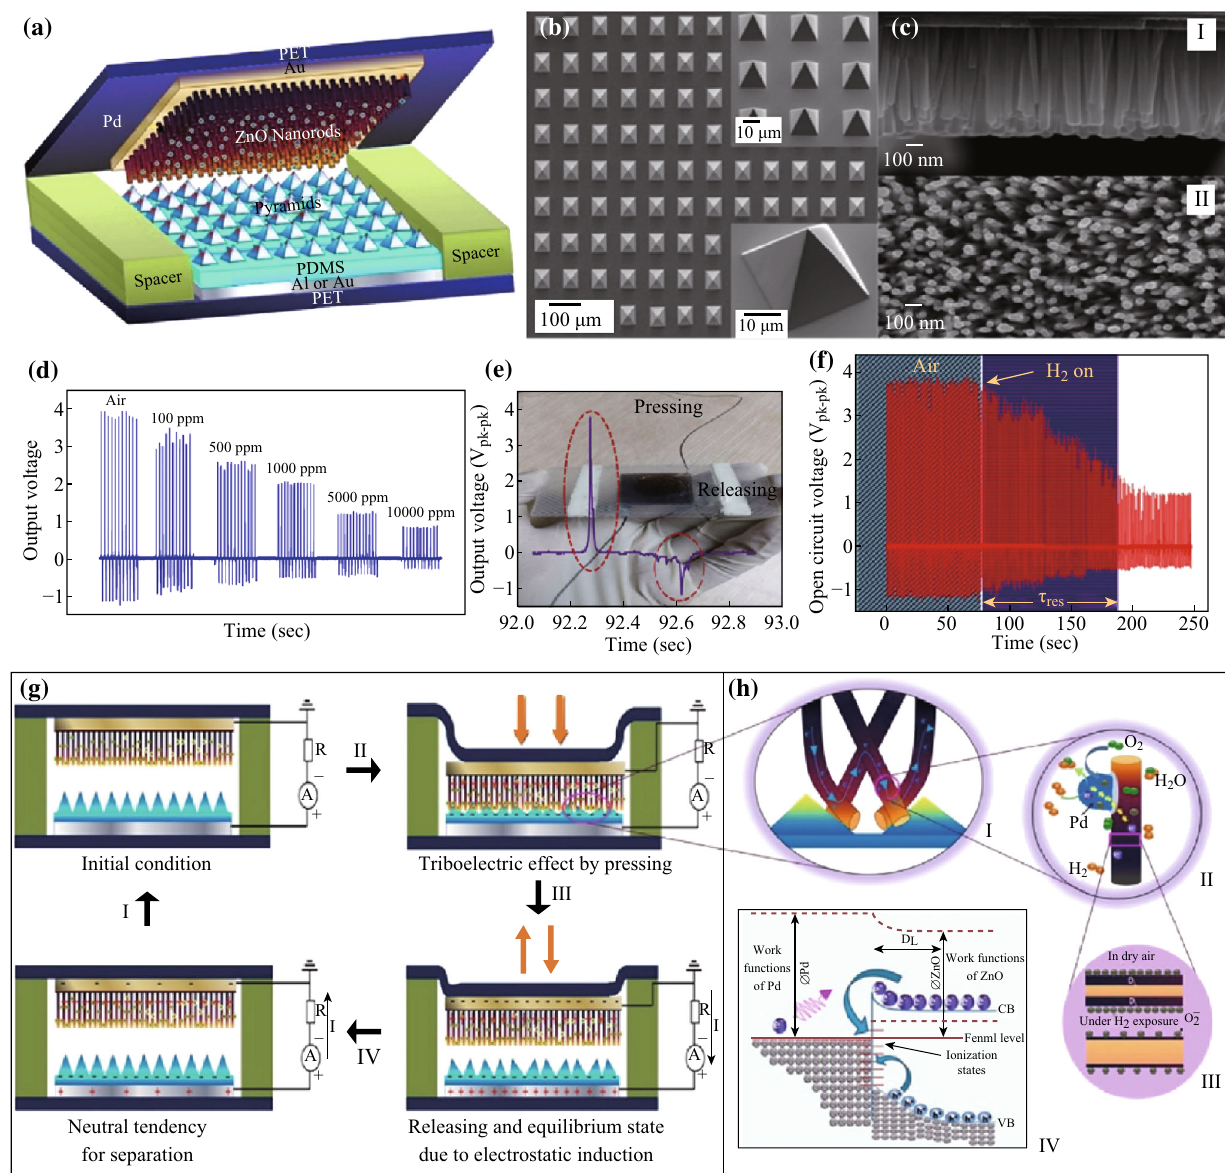
Fig. 9 A self-powered active hydrogen gas sensor with fast response at room temperature based on triboelectric effect. a Schematic of the as- fabricated triboelectric-based H 2 sensor (TEHS). b FESEM images of the micropatterned PDMS surface (the insets show the enlarged view of the micropyramids PDMS). c Cross-section (I) and in-plane (II) micrographs of ZnO nanoparticles. d Variation of open-circuit voltage with and without H 2 exposure. e The pressing and releasing signal peaks of the TEHS. f Response time characteristics of the TEHS. Schematic of the TEHS’s g triboelectric and h sensing mechanisms. Figures adapted from